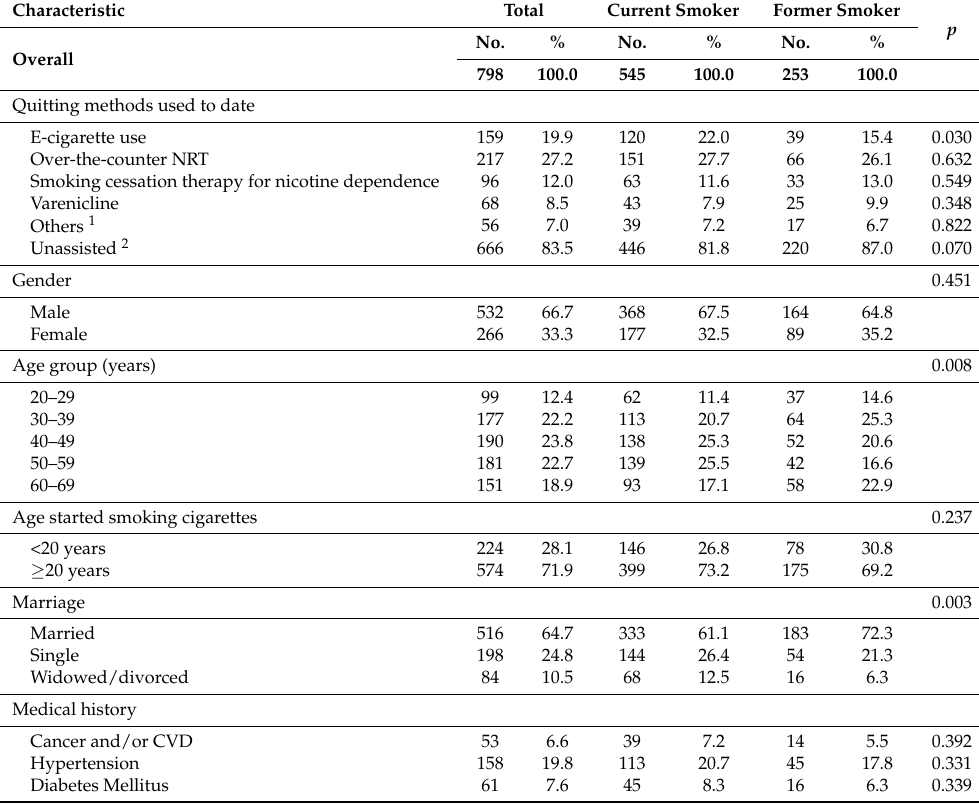
Table 1. Characteristics of 798 persons who smoked within the previous 5 years according to present smoking status for combustible